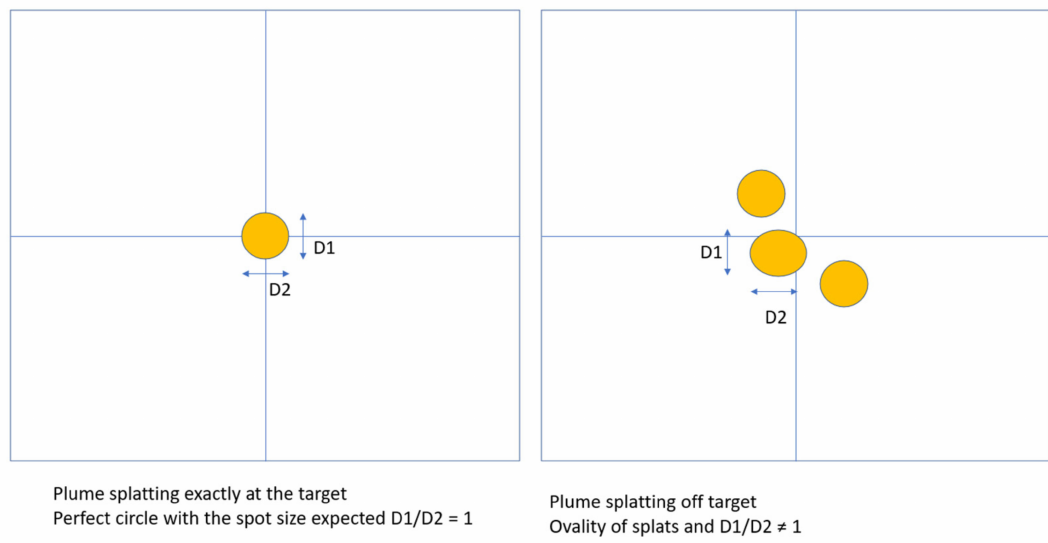
Figure 8. Plume study on a flat plate (author’s own